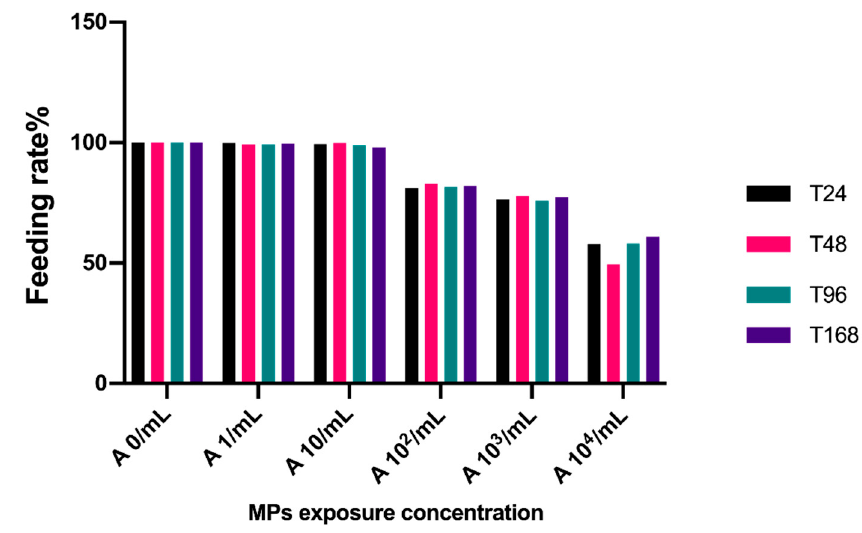
Figure 7. Artemia salina feeding rate (%) at each concentration and experimental time.